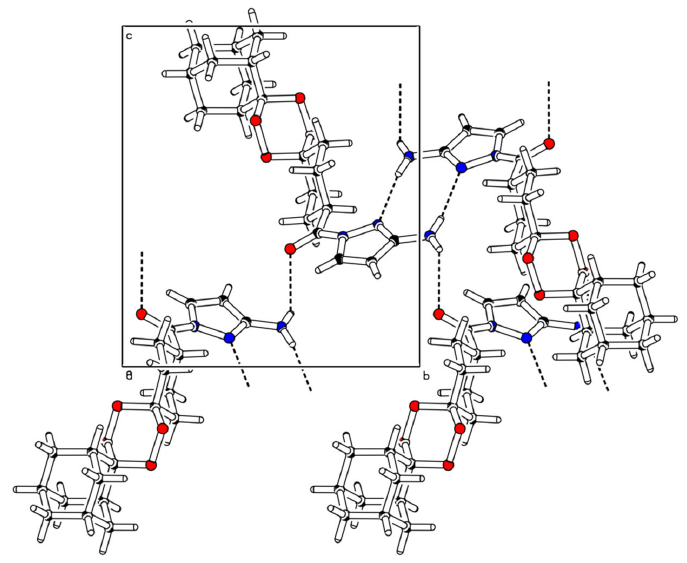
Figure 4. Hydrogen ‐ bonding motif in the crystal structure of isomer T1.